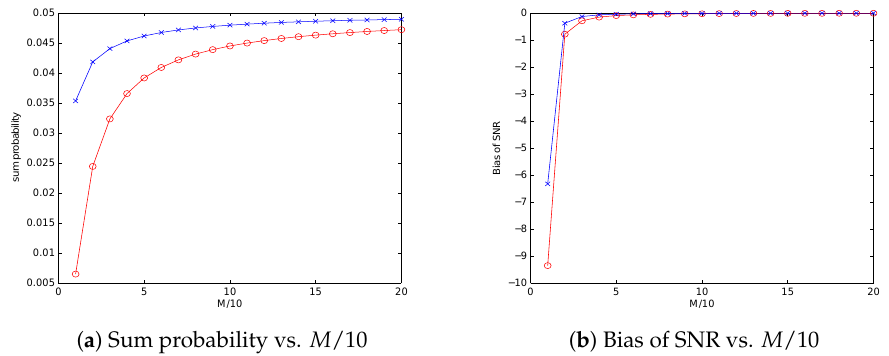
Figure 7. The plot for Example 6 under the setting M = 10 k , k = 1,2, . . . ,20, under setting α = 0.05 and σ n = 1. ( a ) The plot of the constraint summation probabilities of (NP 2 ) and ( and “-x”, respectively. ( b ) The plot of the bias between the SNR solutions from either (NP 2 ) or ( and the asymptotical Equation (62), marked by “-o” and “-x”,